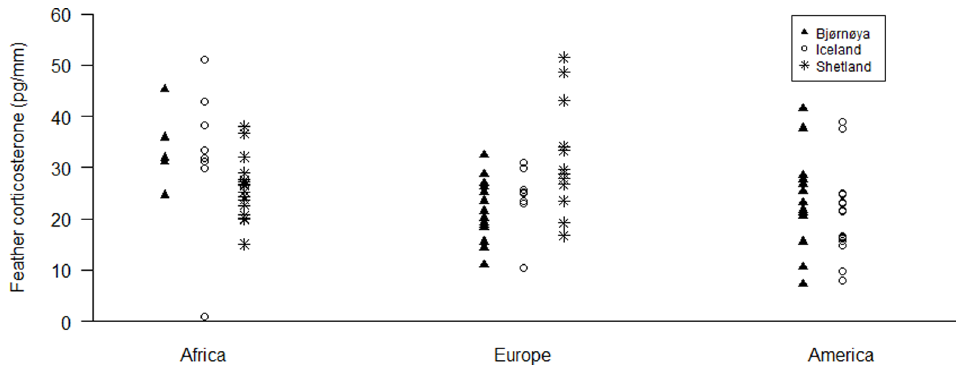
Figure 1. Individual feather corticosterone concentrations in winter grown primary feathers of great skuas ( Stercorariusskua ) breeding in three different colonies: Bjørnøya (black triangles), Iceland (white circles) and Shetland (black stars) in relation to their wintering quarters: Africa, Europe and America.